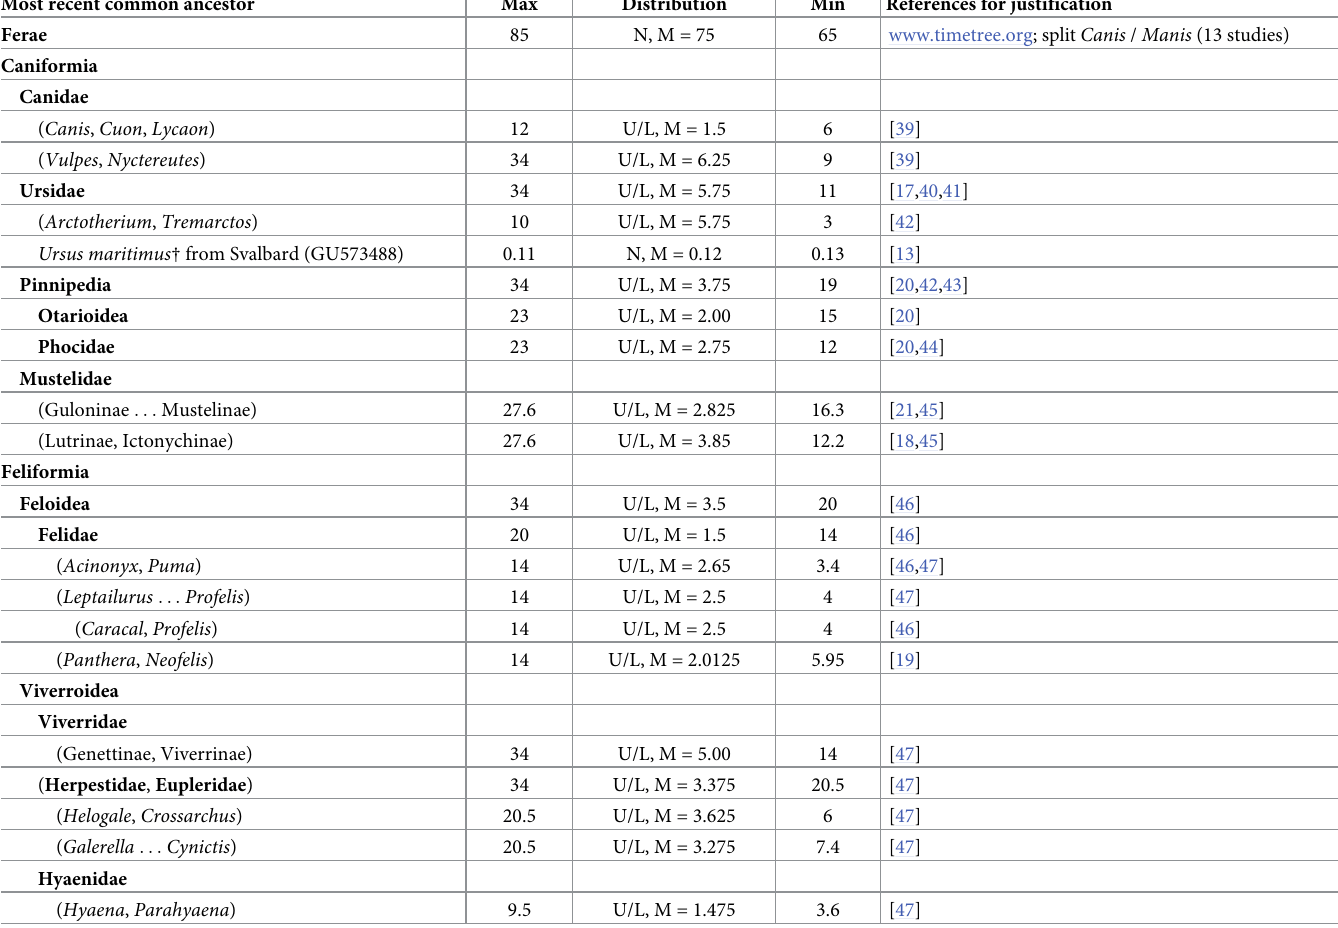
Table 1. Maximum (Max) and minimum (Min) age calibrations (in millions of years ago, Mya) used for molecular dating analyses (with either uniform or log-nor- mal prior distributions [U/L] on calibrated node ages interpreted from the fossil record). Most recent common